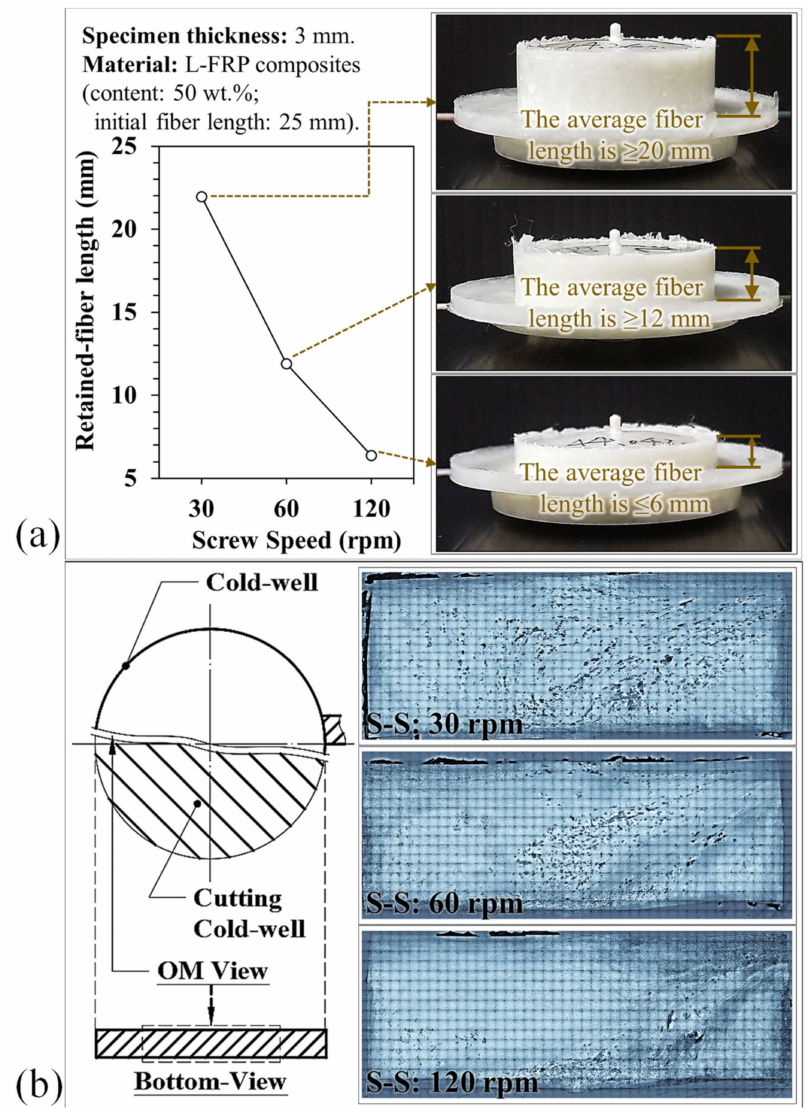
Figure 5. Optical scanning and observation of the cold well at different fiber breaking lengths (screw speeds of 30, 60, and 120 rpm) with the right-angle gate: ( a ) fiber stagnation, and ( b ) fiber flow and